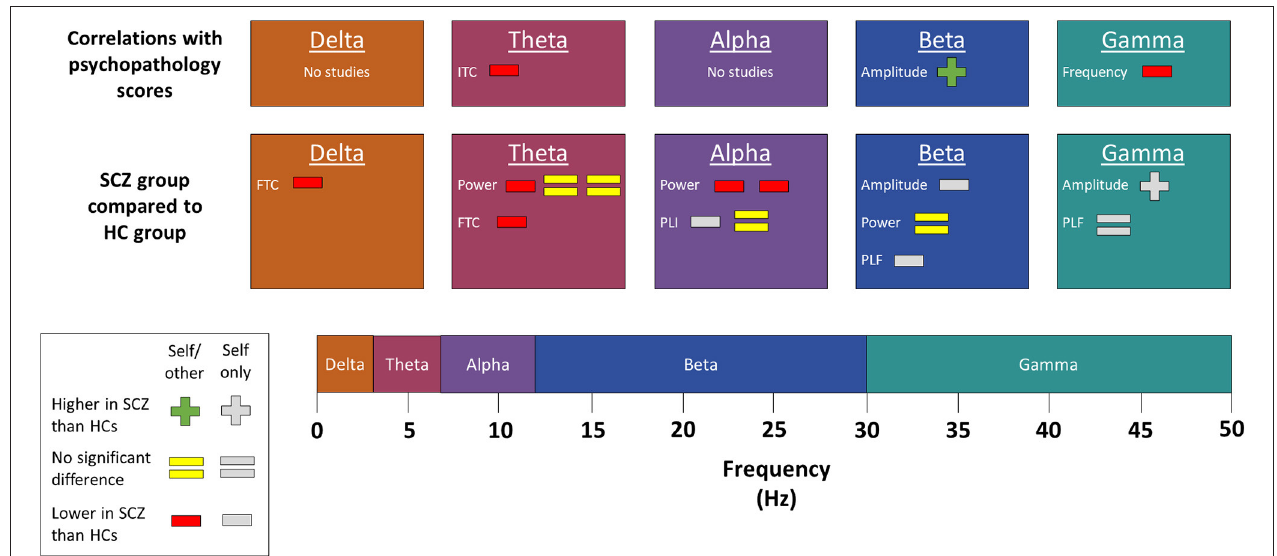
FIGURE 5 | Changes in individual frequency bands. Results comparing individual frequency bands in subjects with schizophrenia to those in healthy controls. SCZ, subjects with schizophrenia. HCs, healthy controls. FTC, frontotemporal coherence. ITC, intertrial coherence. PLI, phase lag index. PLF, phase-locking factor. The presence of multiple signs beside one measure indicates multiple separate results. Studies marked as “self/other” either compared self-related task data to similar non-self-related task data or else correlated their findings with a psychopathology scale that measures self disorder. By contrast, studies marked as “self only” used neither of those methods to establish whether the observed change was related to the self. Most of the studies included in this figure used a source monitoring paradigm. However, the following results were from other paradigms. Self-referential processing paradigms were used by Jia et al. ( 25), who found no difference in theta or beta power but decreased alpha power and phase lag index. Proprioception paradigms were used by Arnfred et al. (22), who found decreased beta amplitude and phase-locking factor, increased gamma amplitude, and no difference in gamma phase-locking factor, and Arnfred et al. ( 23), who found a positive correlation between beta amplitude and psychopathology scales but a negative correlation between gamma frequency and psychopathology